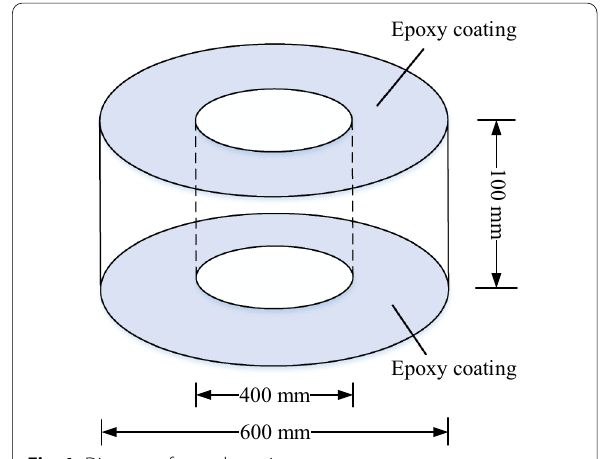
Fig. 1 Diagram of tested specimens.